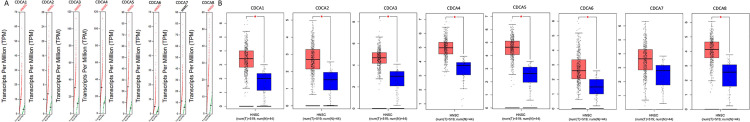
The box plot expression of CDCAs in HNSCC (GEPIA database).